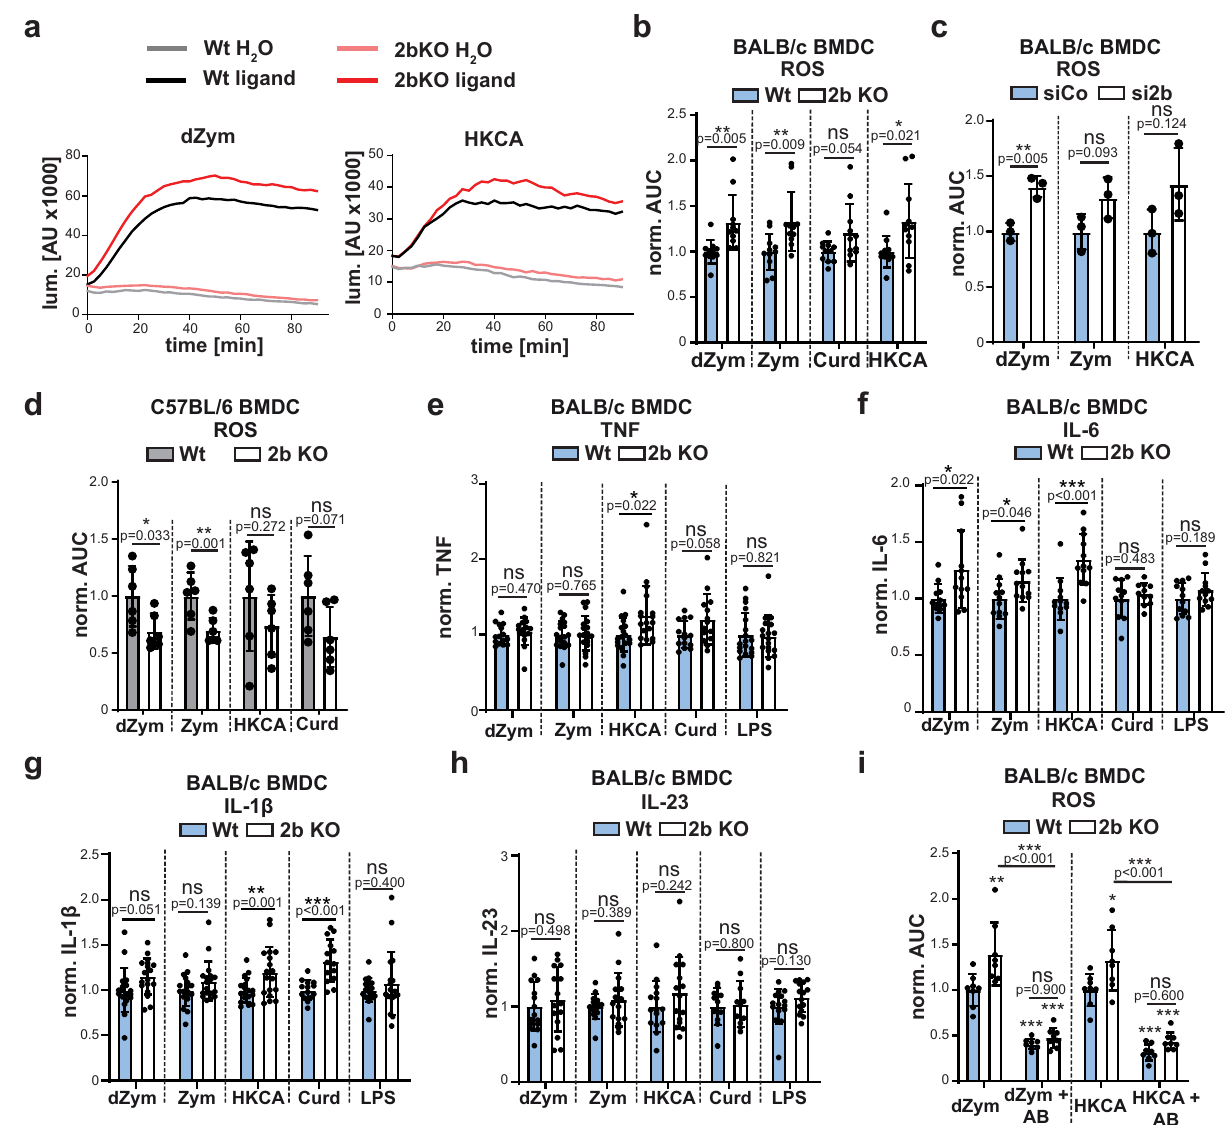
Fig. 5 SPPL2b regulates ROS production in response to Dectin-1 ligands. a BMDCs from BALB/c wild type (Wt) or SPPL2b knockout (2b KO) mice were treated with 50 µ g/ml depleted Zymosan (dZym) or MOI 10 heat-killed C. albicans (HKCA). ROS formation was detected using the luminometric